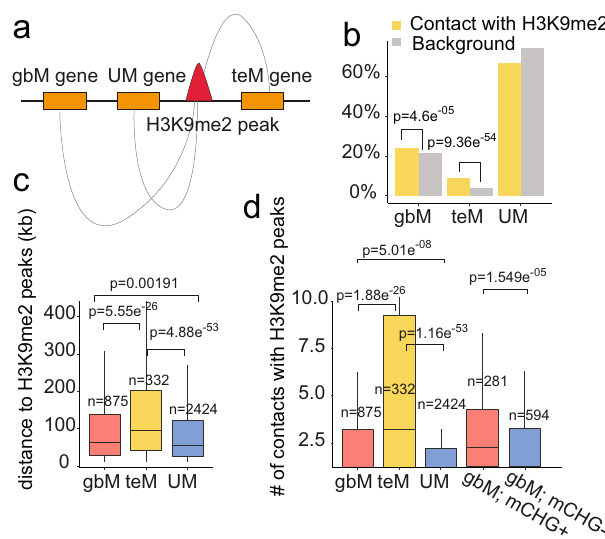
Fig. 6 Loci that are susceptible to spontaneous epiallele formation have a greater contact frequency with H3K9me2 region. a Hi-C data was used for identifying signi fi cant three-dimensional contacts between genomic regions. The schematic plot depicts the interaction from regions possessing H3K9me2 and genes. b Enrichment test for genes that have contacts with H3K9me2. Yellow bars show the proportion of each type of genes that contacts with H3K9me2. Grey bars show the proportion of each type genes in comparison with all coding genes. Fisher ’ s exact test was used for enrichment test. p -value is based on one-sided test with alternative hypothesis that odds ratio is greater than 1. c Distribution of distance between three types of genes (gbM, UM, teM) and H3K9me2 regions. Two-sided Wilcoxon tests was used for pairwise comparison of each two groups without adjustment for multiple comparisons. d Distribution of the number of contacts between three types of genes (gbM, UM, teM) and H3K9me2 regions. gbM genes were further classi fi ed into a group with ectopic mCHG (gbM; mCHG + ) and a group without ectopic mCHG (gbM; mCHG-) based on ddm1 mutant line data. Two-sided Wilcoxon tests was used for pairwise comparison of each two groups without adjustment for multiple comparisons. Box plots show a median center line, the lower and upper hinges are the fi rst and third quartiles. Whiskers represent 1.5x the interquartile range. Source data underlying Fig. 6b – d are provided as a Source Data fi